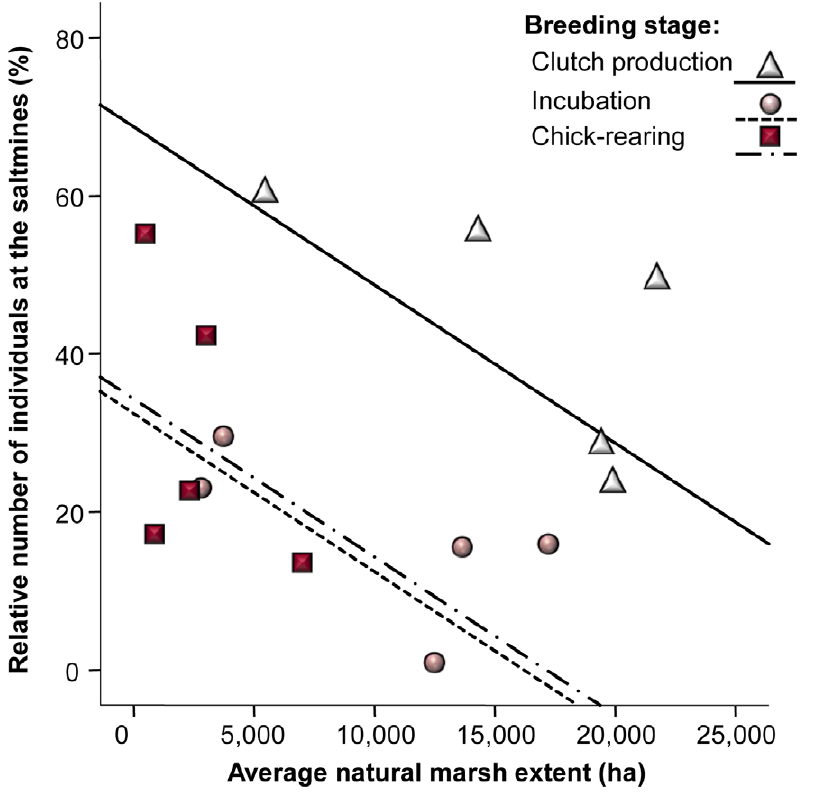
Figure 4. Linking natural resource availability with feeding habitat choice. Relationship between the estimated flooded area at the natural marshes (ha) during the clutch-production, the incubation and the chick-rearing period, and the proportion of adult gulls (i.e. respect the total number of reproducing birds) observed at the saltmines, i.e. the main alternate foraging habitat.